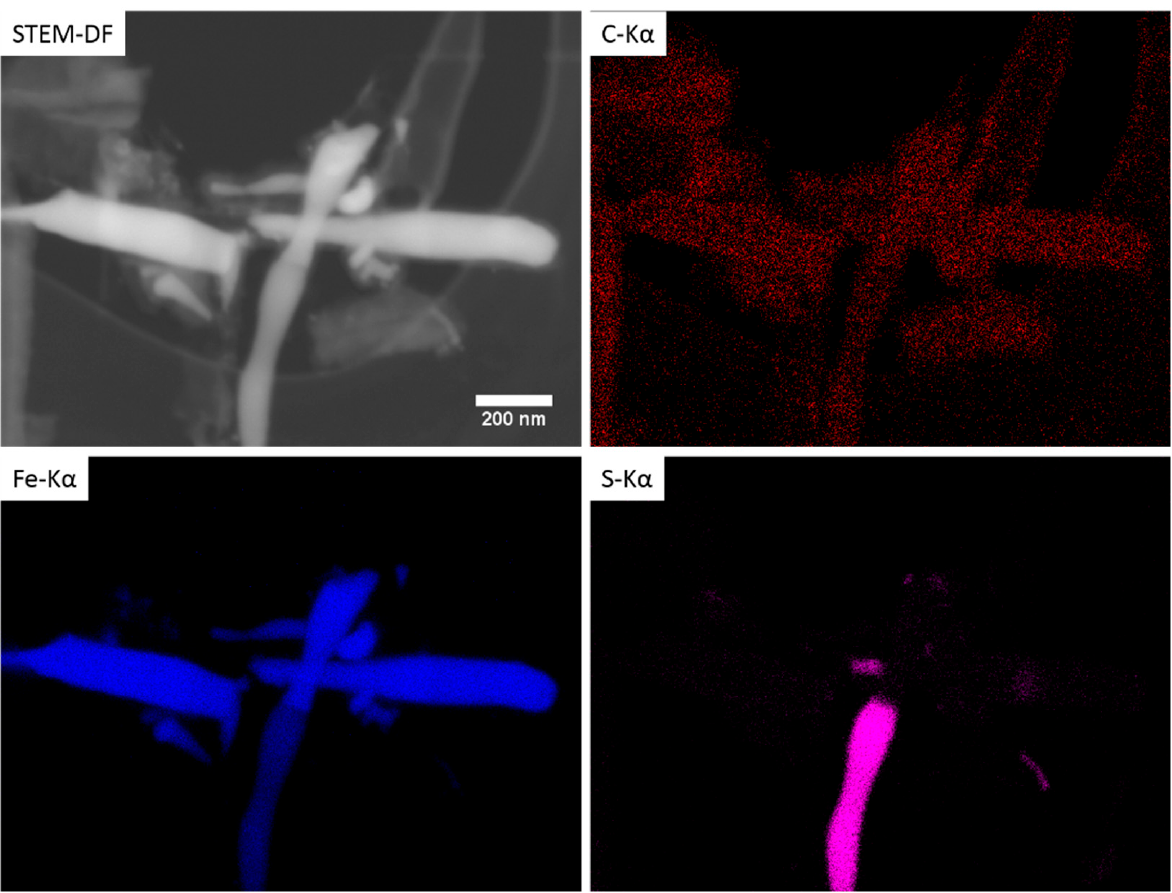
Figure 3. Elemental X-ray map of SCNA8 sample in STEM mode at E0 = 20 kV.